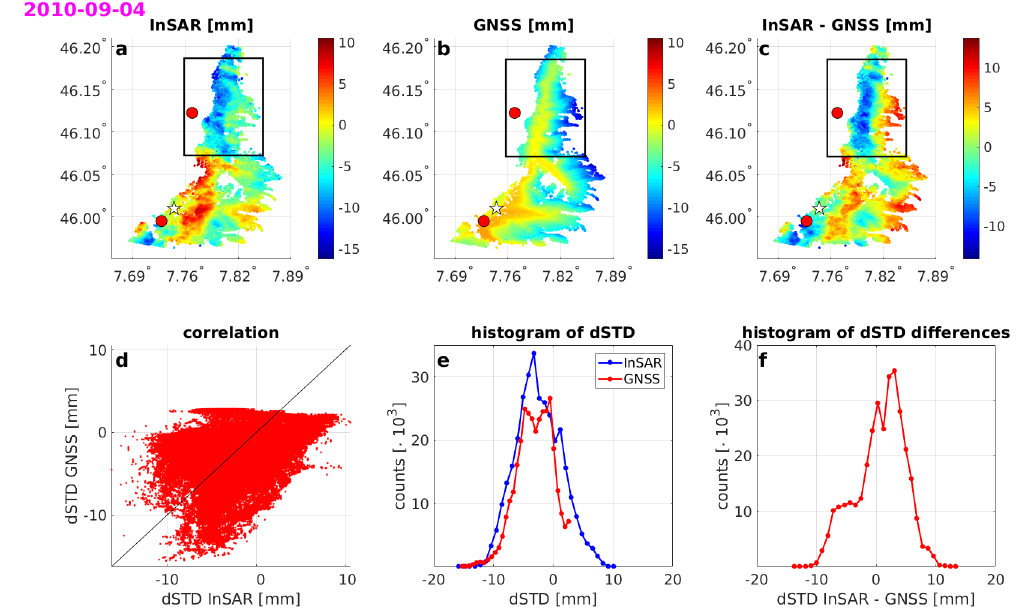
Figure 9. Comparison between InSAR and GNSS for a day with a poor agreement (4 September 2010). The plots show ( a ) InSAR-based dSTD s for all PS points; ( b ) GNSS-based dSTD s for all PS points; ( c ) the differences between ( a , b ); ( d ) the correlation between techniques; ( e ) the histograms of dSTD values for both techniques and ( f ) the histogram of differences dSTD InSAR − dSTD GNSS . The white star indicates the reference point and red dots the GNSS stations within the research area. The rectangles in ( a – c ) denote the area with the negative correlation between InSAR and